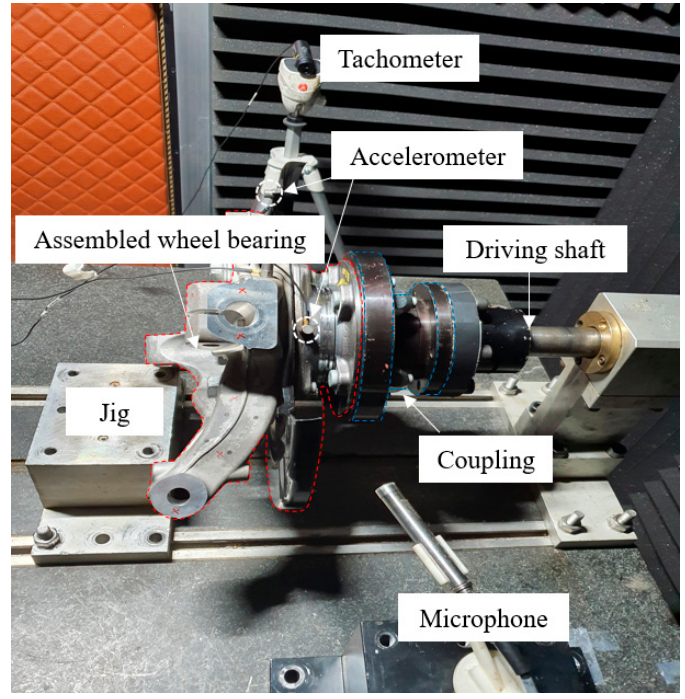
Figure 2. Experimental setup for measuring the noise and vibration of an assembled wheel bearing. First, the characteristics of the noise and vibration generated on the assembled wheel bearing were investigated. The time responses for the noise and vibration, when the assembled wheel bearing rotates at a constant speed of 200 rpm, are shown in Figure 3. Furthermore, Figure 3a shows the time response for noise while an A-weighting filter is applied. Figure 3b,c show the time responses of the vibration of the dust shield and outer ring, respectively. In Figure 3a, the root–mean–square value for the noise response is 9.34 mPa(A) on a linear scale and 53.4 dB(A) on a logarithmic scale. In Figure 3b,c, the root–mean–square values for the vibration responses are 0.76 m/s 2 and 0.19 m/s 2 , respectively. The vibration of the dust shield was approximately four times higher than that of the outer